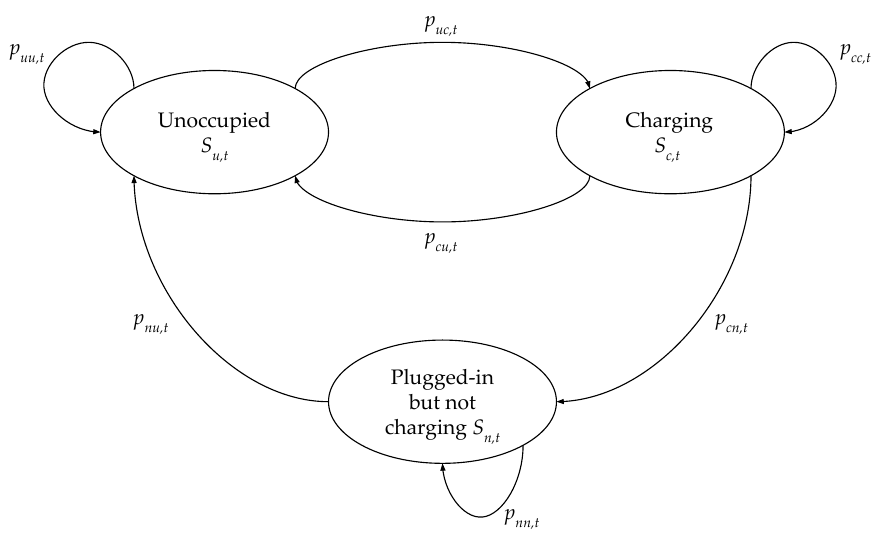
Figure 1. Markov chain transition